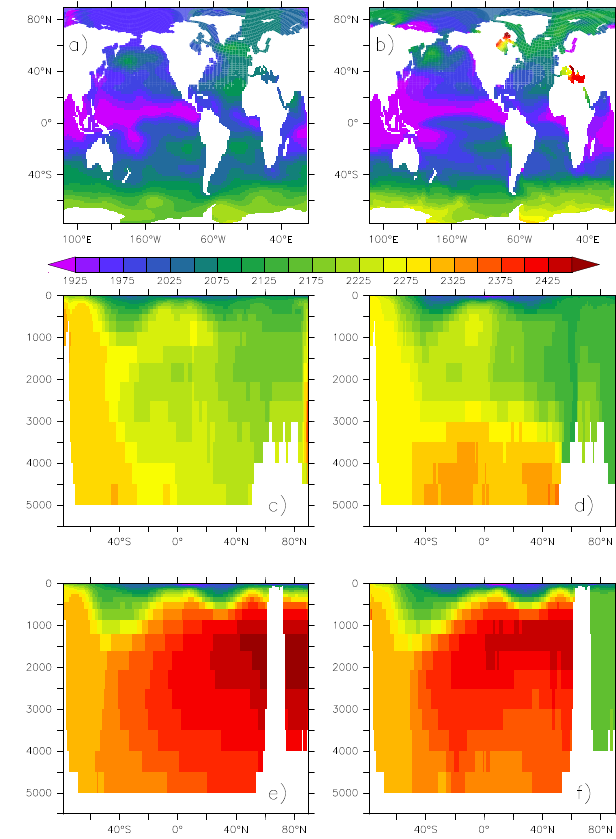
Figure 12. Annual-mean natural DIC concentrations in µmolL − 1 . Observations are from GLODAP. The pre-industrial distribution of DIC has been estimated in GLODAP as the difference between total DIC and anthropogenic carbon. Panels are the same as on Fig.